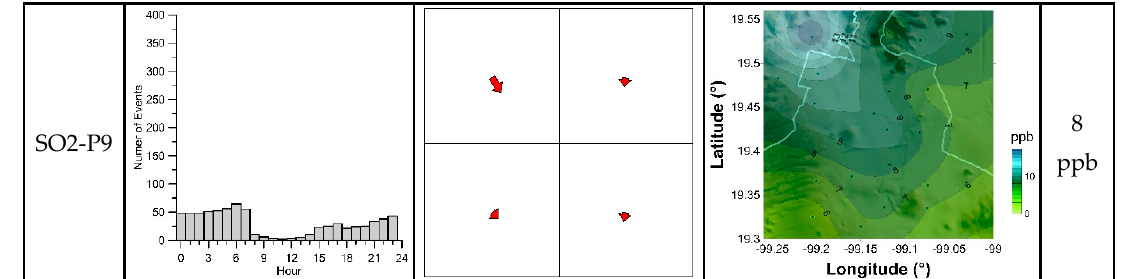
Figure 12. Flow patterns of sulfur dioxide in the Mexico City region during the period 2001–2010. For each flow pattern, the figures show the hourly population (second column), the mean flow vectors (relative to the pattern) at the city quadrants (third column), the surface concentration distributions (fourth column) averaged over the events of the flow pattern, and the mean spatial concentration (last column). The size of red arrows that stand in for the SO 2 flow vectors indicates the flow intensity in a scale relative to the edge size of the squares that represent the quadrants.